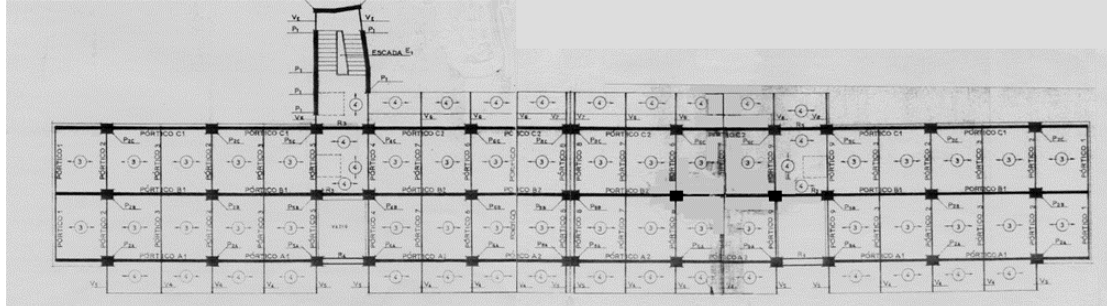
Figure 4. Structure plan of the intermediate floor and basement.